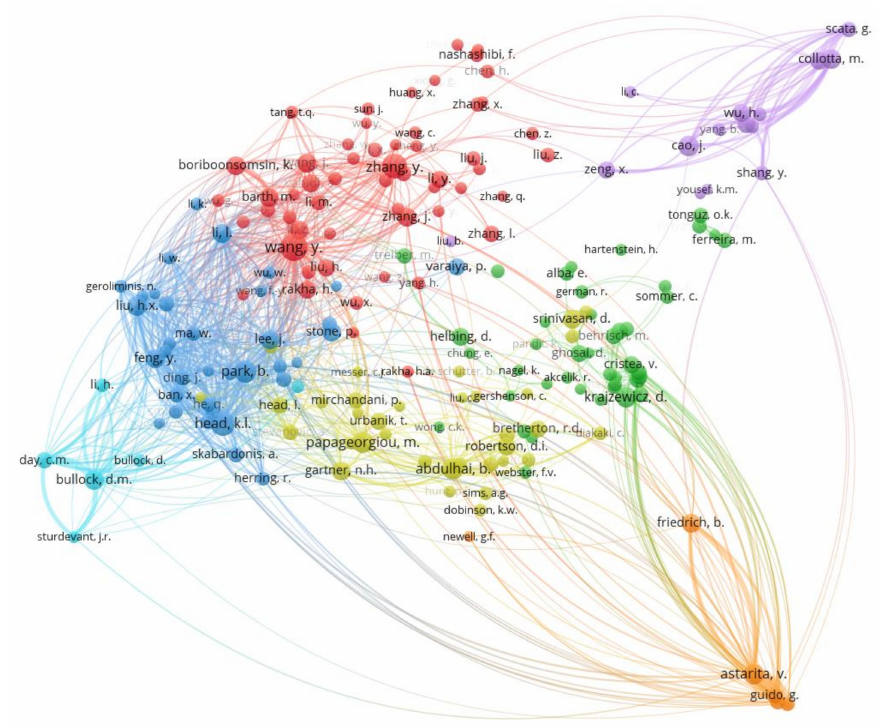
Figure 7. Author visualization of database list “A” obtained by analyzing